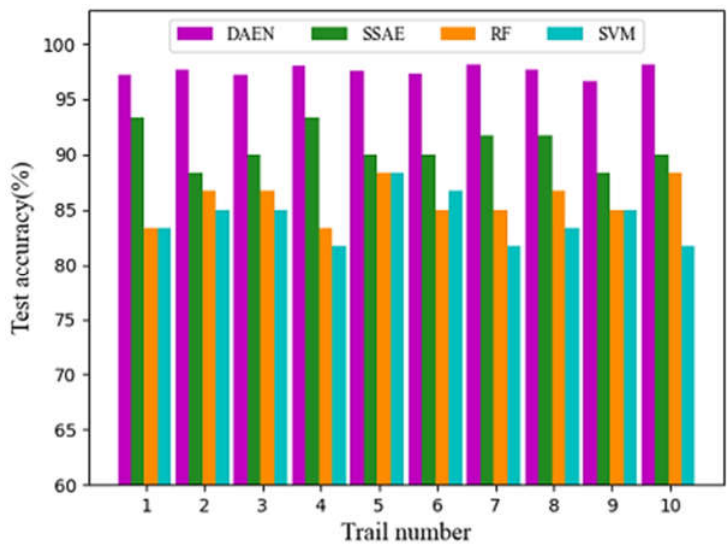
Figure 7. Comparison of experimental results. Table 3. The average accuracy and standard deviation.